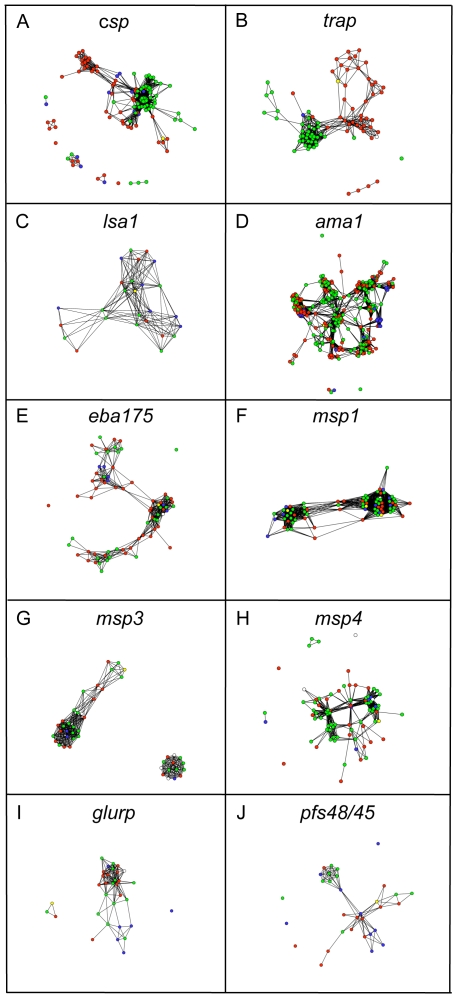
Global population structure of the genes encoding ten P. falciparum vaccine antigens based on network analysis.Networks of nsSNP haplotypes were drawn by first removing multiple copies of each haplotype , leaving only one copy per country for the analysis. Hence, identical haplotypes from different regions, but not within regions were included. Each node (coloured circle) represents a haplotype, shaded by region of origin: Red = Africa, Green = Asia, Blue = Americas. Nodes are tied by edges (black lines) demonstrating that they share a predefined threshold (t) of nsSNPs for csp = 24; trap = 67; lsa1 = 8; ama1 = 48; eba175 = 18; msp1 = 5; msp3 = 63; msp4 = 19; glurp = 18; pfs48/45 = 23. Vaccine haplotypes are shaded in yellow. Haplotypes originating from isolates with unknown origin are shaded in white (unless they were vaccine haplotypes).